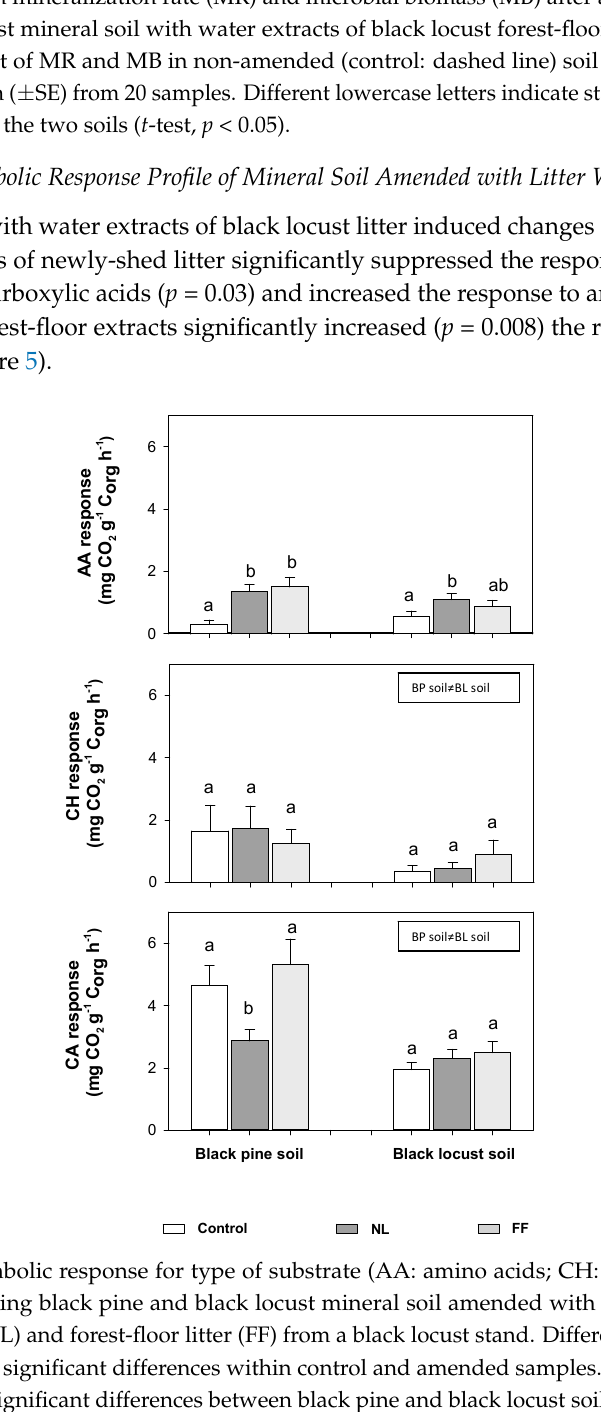
Figure 5. Mean catabolic response for type of substrate (AA: amino acids; CH: carbohydrates; CA: carboxylic acids) using black pine and black locust mineral soil amended with water extracts from newly ‐ shed litter (NL) and forest ‐ floor litter (FF) from a black locust stand. Different lowercase letters indicate statistically significant differences within control and amended samples. In the boxes within panels statistically significant differences between black pine and black locust soil (two ‐ way ANOVA, p < 0.05) are shown.